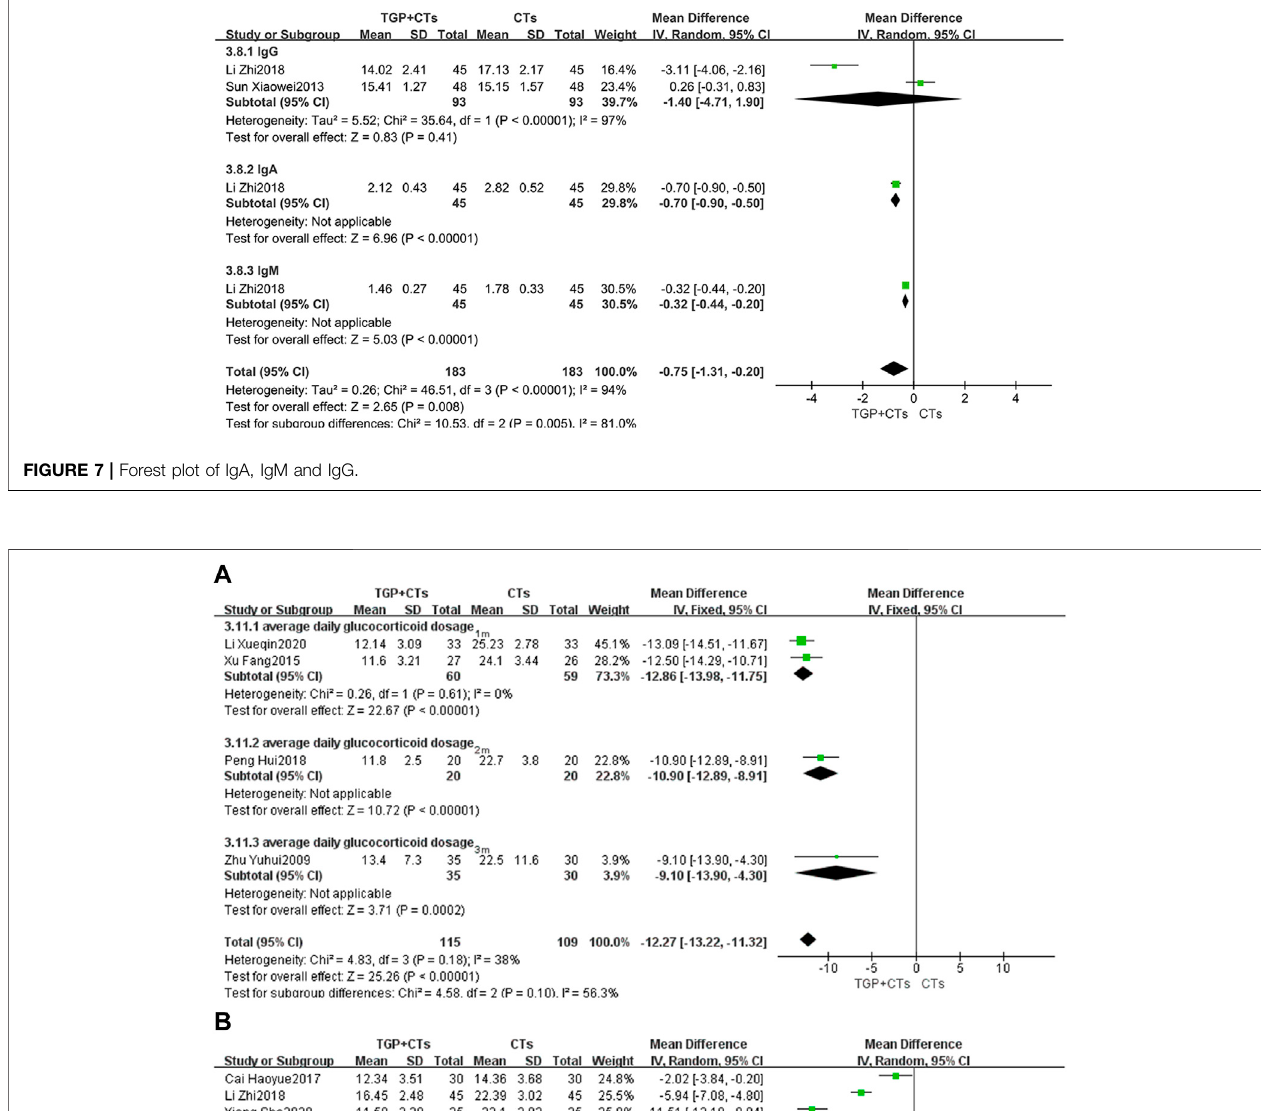
Frontiers in Pharmacology |